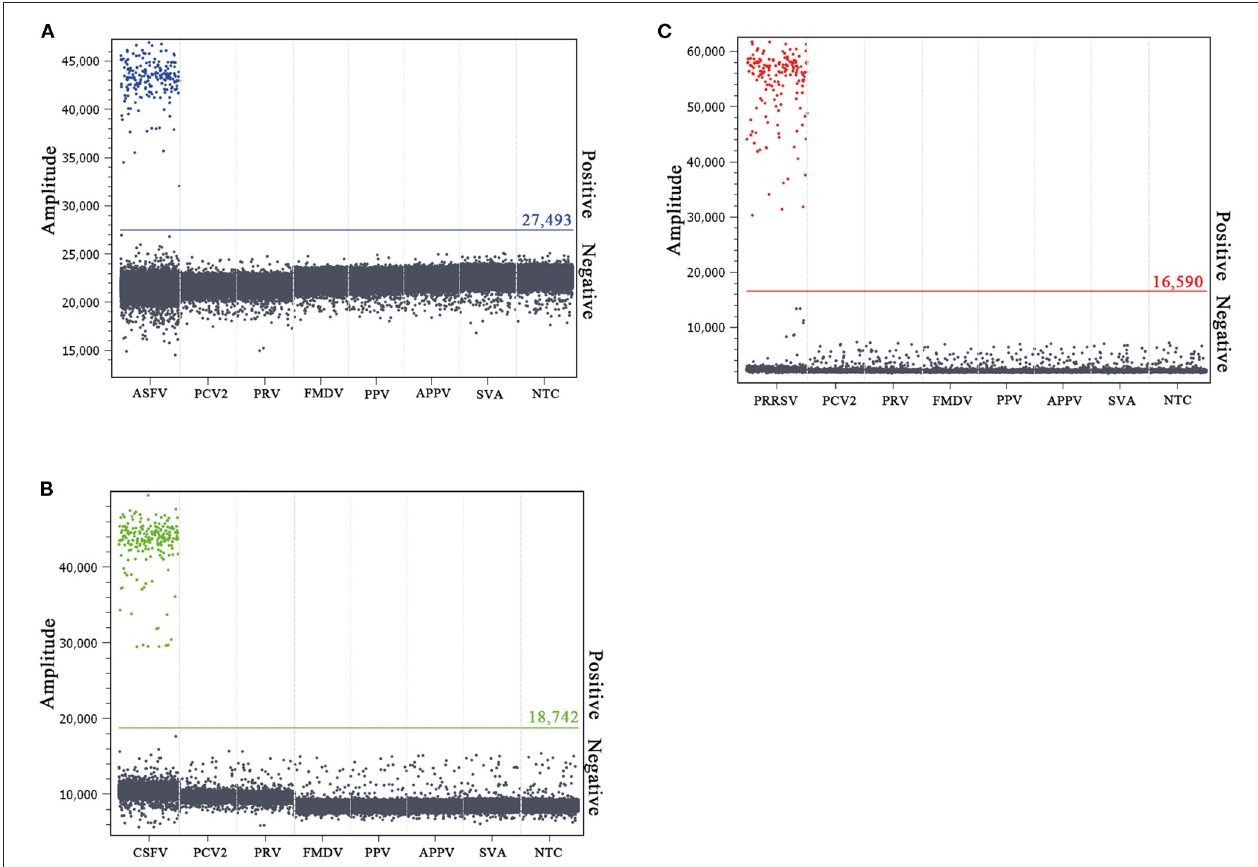
FIGURE 3 | Specificity analysis of the multiplex crystal dPCR for detection of ASFV (A) , CSFV (B) , and PRRSV (C) . The fluorescence amplitudes of ASFV, CSFV, PRRSV, FMDV, SVA, APPV, PRV, PCV2, and PPV were showed. NTC: no template